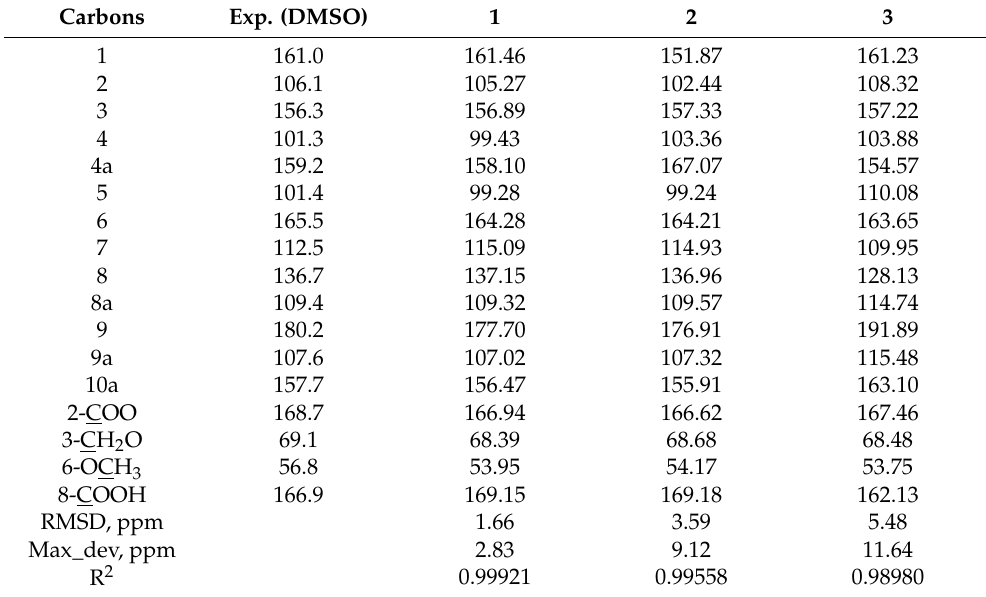
Table 2. Experimental and DFT-calculated 13 C NMR chemical shifts (ppm) for the three top-ranked candidate structures for ominoxanthone shown in Figures 5 and 6 (for clarity, the provided numbering fits the best-ranked candidate; site-by-site assignments of the two other candidate structures are given in Figure S16, Supplementary Material).